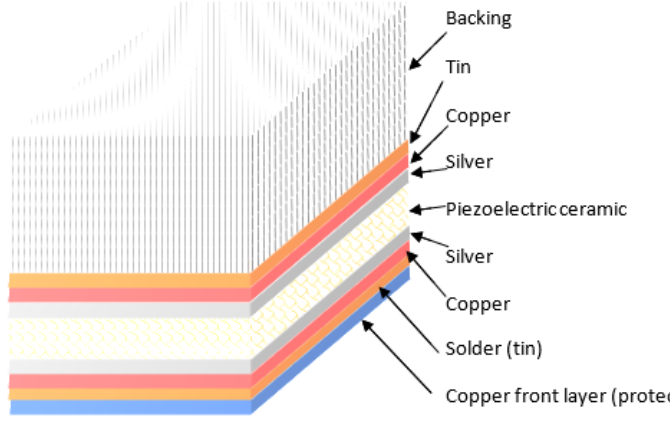
Figure 1. The developed ultrasonic transducer.